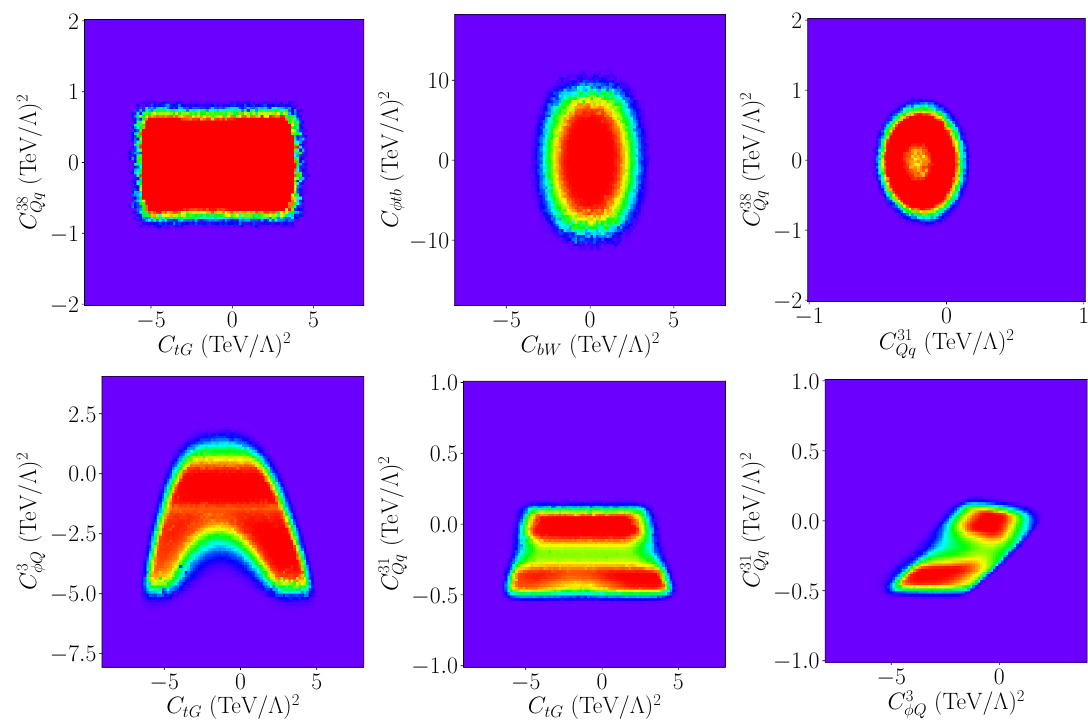
Figure 10 . Upper: examples for correlated 2-dimensional pro(cid:12)le likelihoods of operators in a global (cid:12)t to the single top data. Lower: correlated pro(cid:12)le likelihoods for a three-parameter (cid:12)t of the same